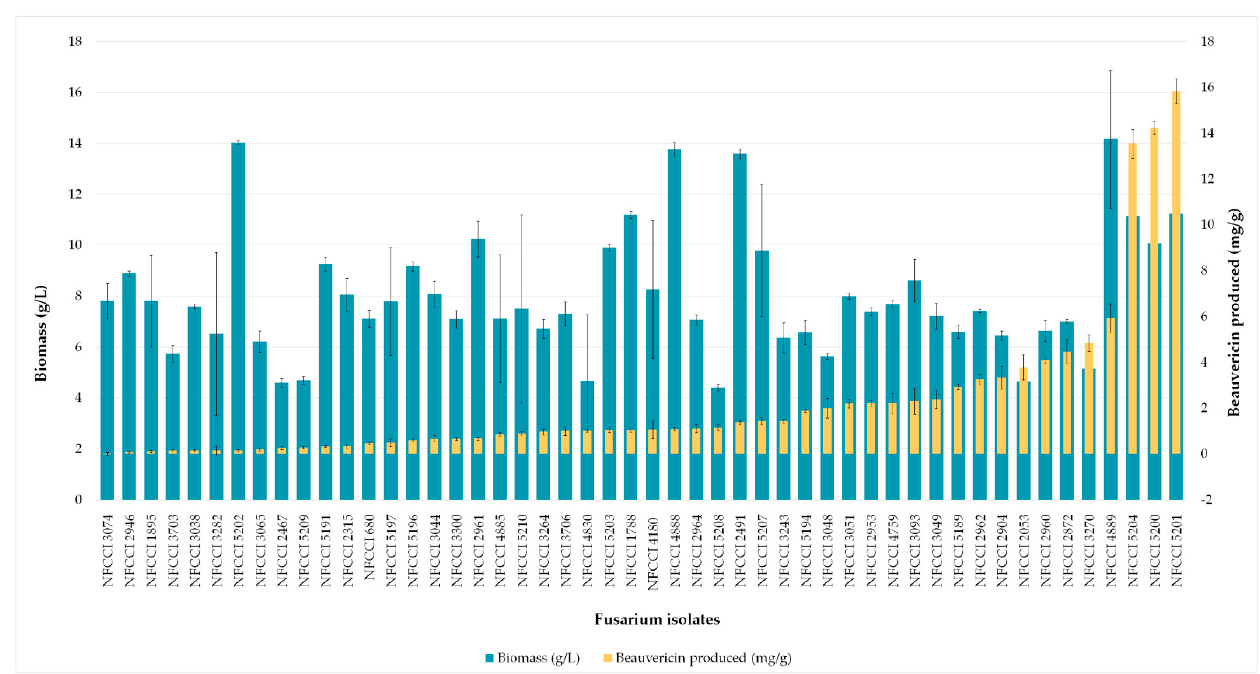
Figure 6. Mycelial biomass and BEA content produced by different Fusarium isolates in the Fusarium defined medium (on day 7).